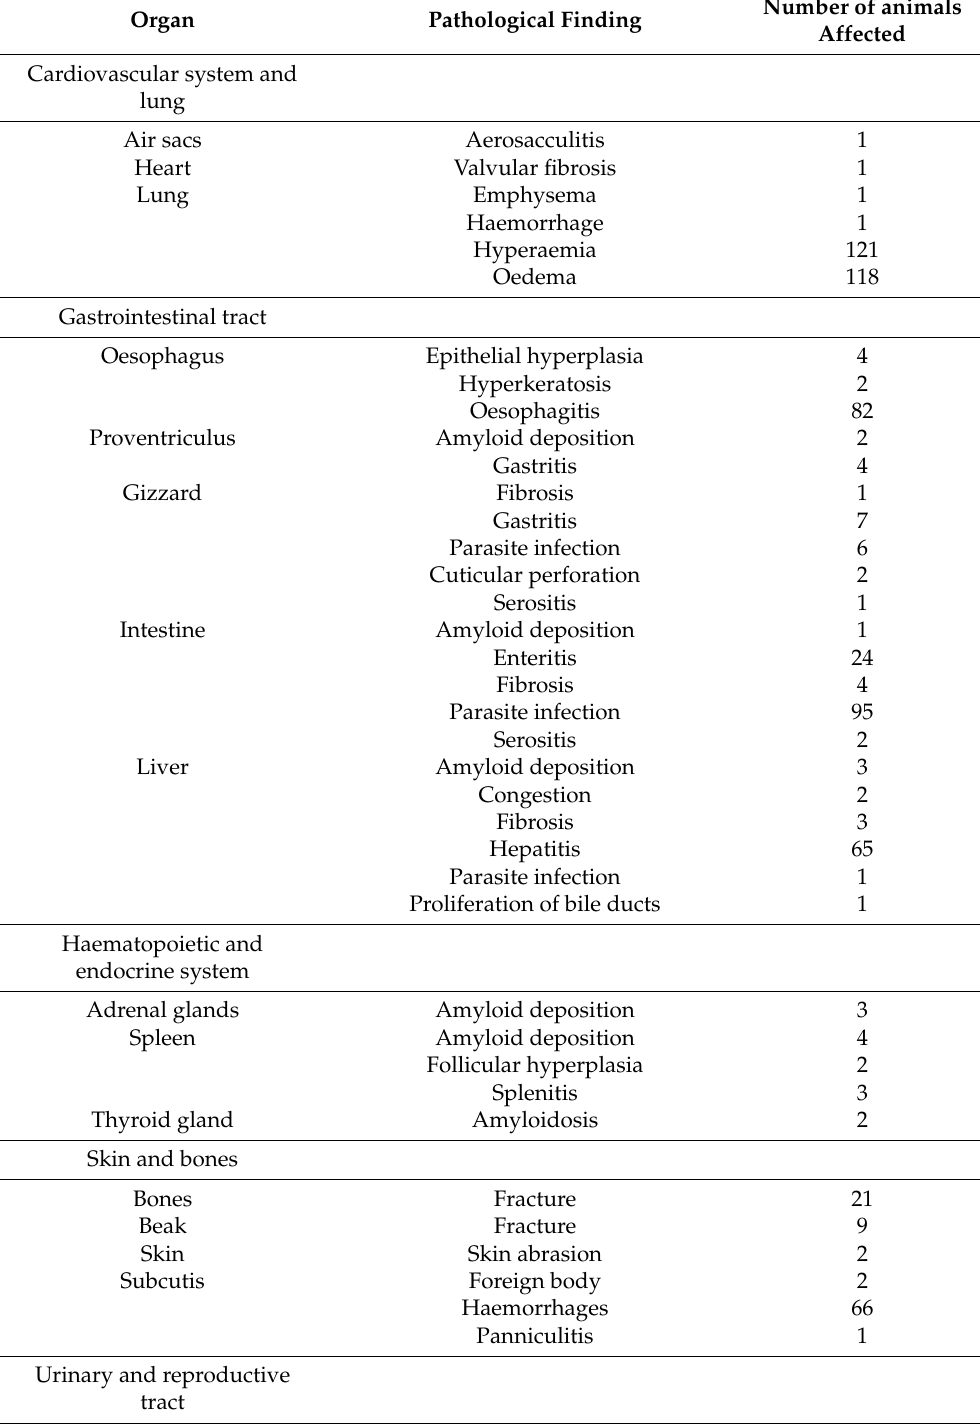
Table 3. Pathomorphological findings of 121 Common Eiders listed by organ systems. Organ Pathological